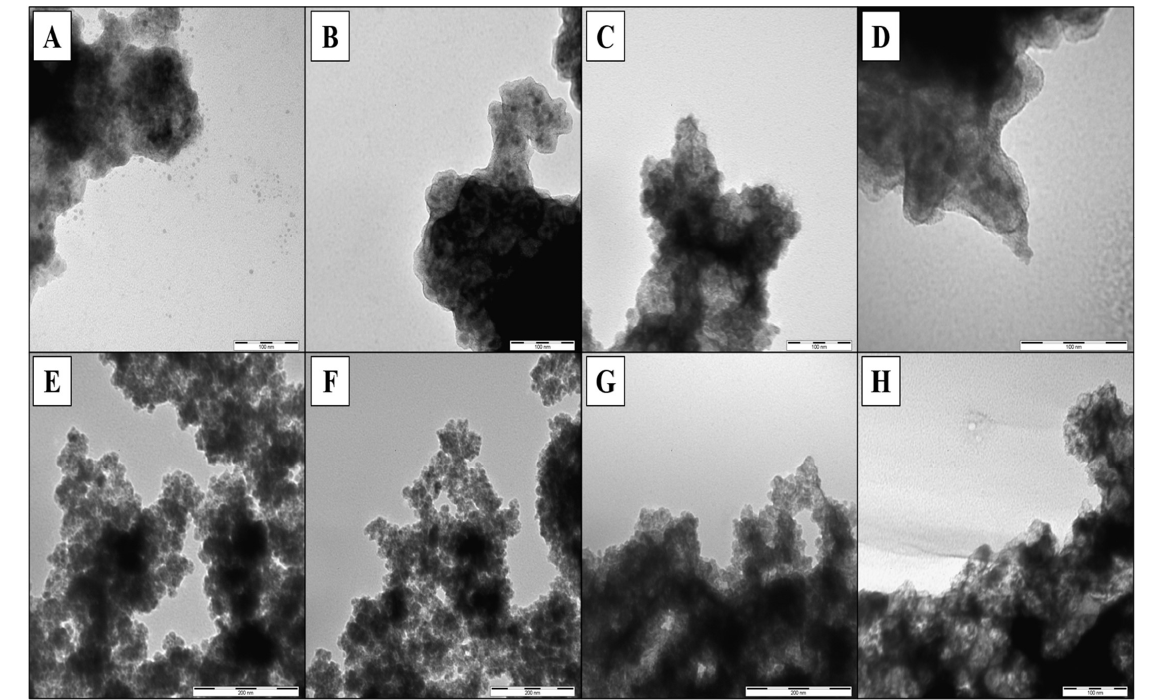
Figure 5. Transmission electron microscopy (TEM) images of MMIPs prepared with different concentrations of dopamine: ( A ) 1 mg/mL (MMIP−PDA1), ( B ) 2 mg/mL (MMIP−PDA2), ( C ) 3 mg/mL (MMIP−PDA3), and ( D ) 4 mg/mL (MMIP−PDA4); their corresponding MNIPs: ( E ) 1 mg/mL (MNIP−PDA1), ( F ) 2 mg/mL (MNIP−PDA2), ( G ) 3 mg/mL (MNIP−PDA3), and ( H ) 4 mg/mL (MNIP−PDA4).